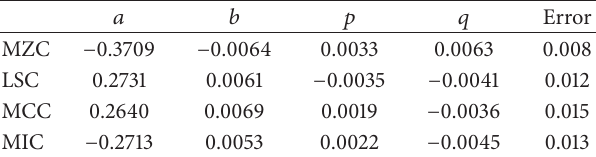
Table 4: The cylindricity error of four methods (/mm).